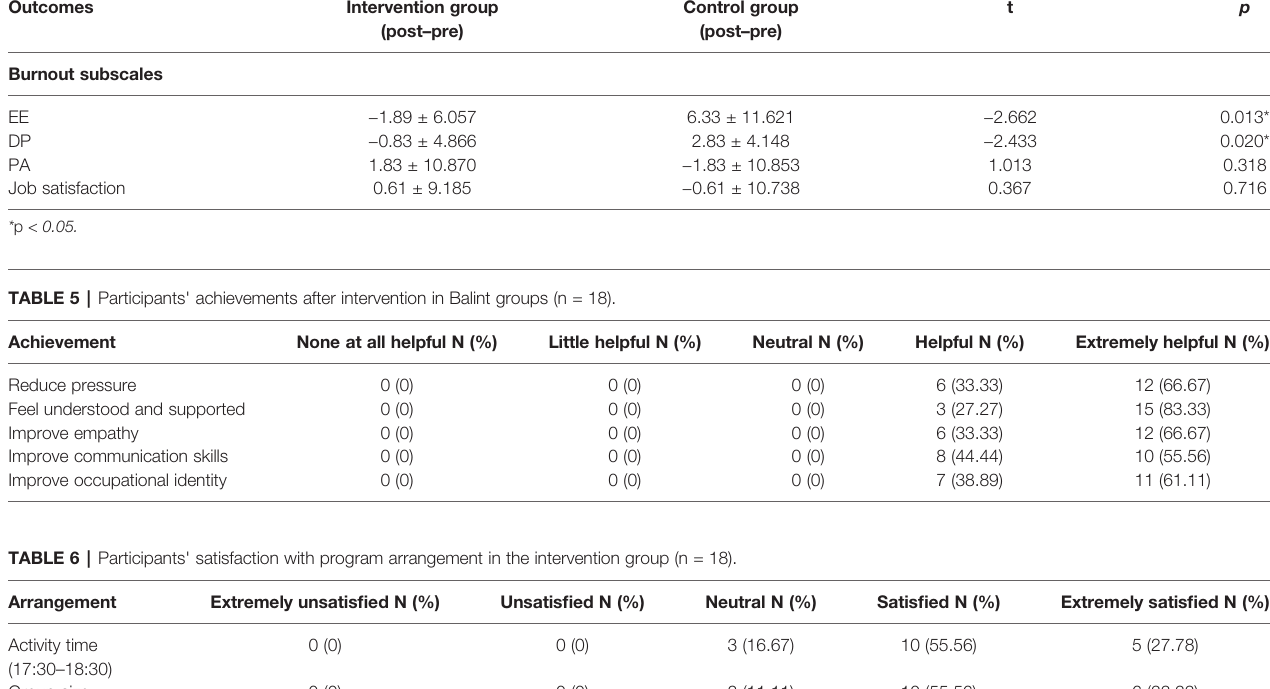
TABLE 4 | Comparison of burnout subscales and job satisfaction scores change between the intervention and the control group ( x ± s). Outcomes